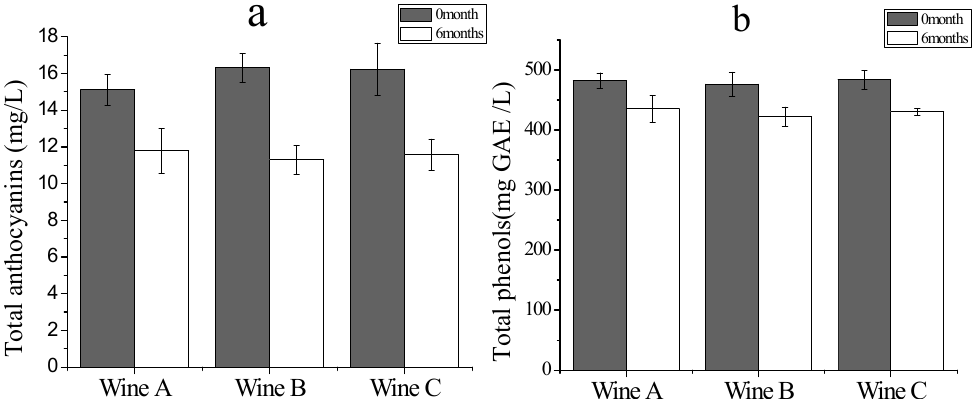
Figure 1. Total anthocyanins ( a ) and total phenols ( b ) of fresh (0 month) and bottle-aged (6 months) bog bilberry syrup wines.